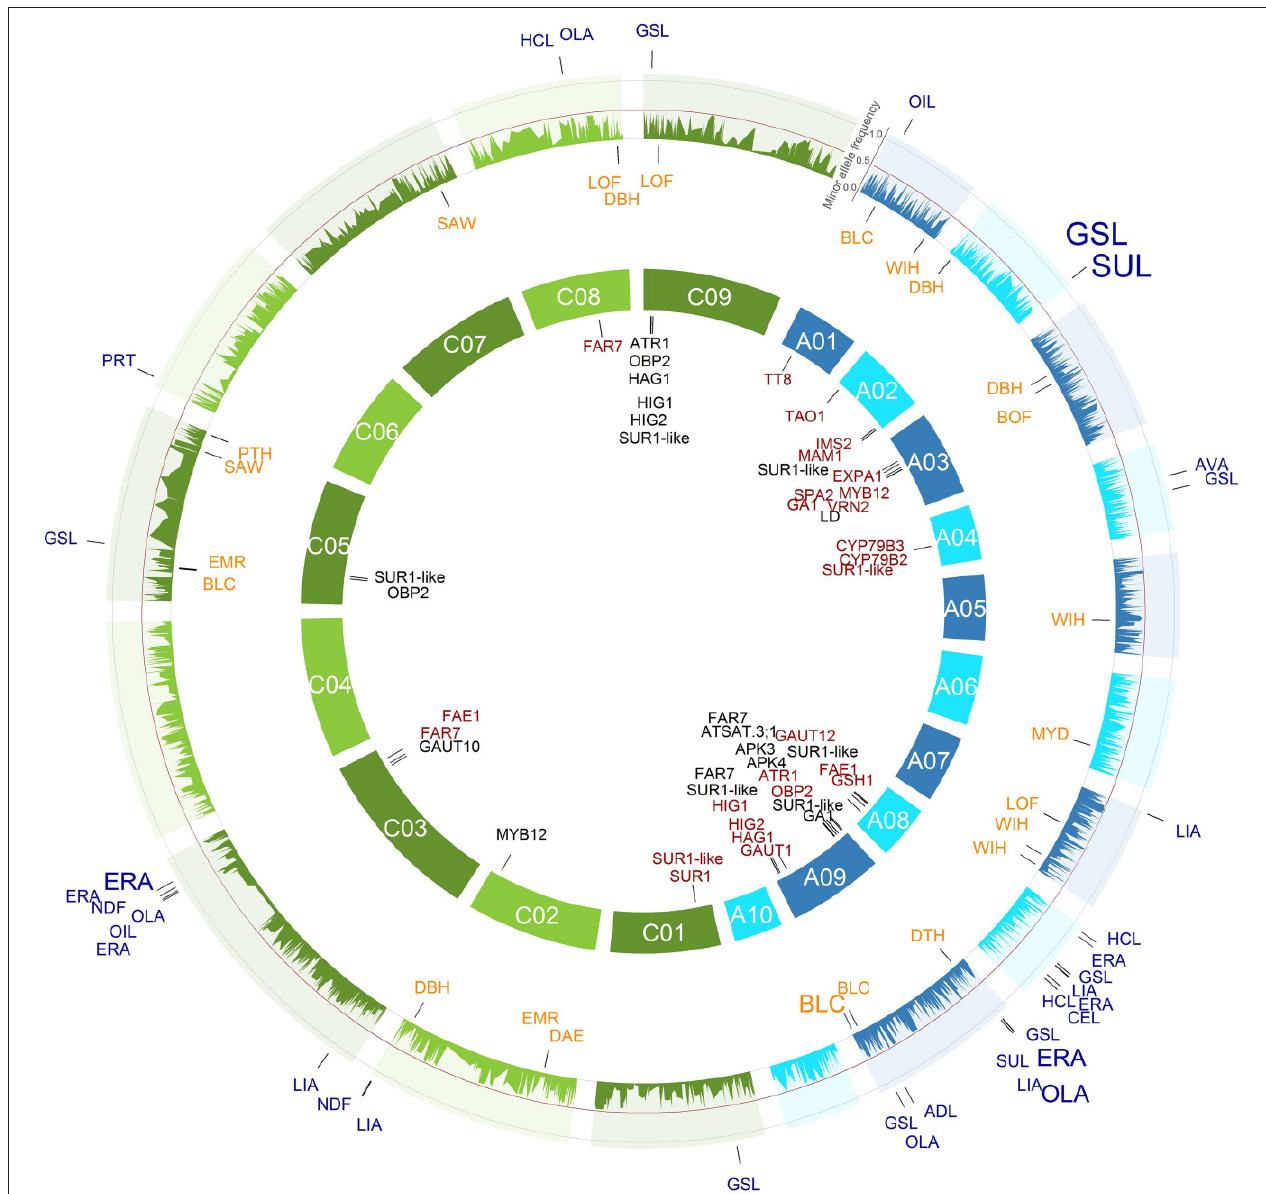
FIGURE 4 | All single nucleotide polymorphism (SNP)-trait associations with a P < 1.28e-05 (Bonferroni correction of α = 0.05 ) identified across the 214 inbreds of the winter trial and their respective positions are marked on the B. napus genome. The 3466 SNPs with their minor allele frequencies in the winter trial are given in the outer circle. The SNPs associated with the agronomic SNP-trait associations are plotted in orange below the allele frequency circle and the seed quality SNP-trait associations in blue outside the allele frequency circle. The size of the letters is related to the proportion of the variance explained by the associations. In the inner circle of the 19 chromosomes, the candidate genes were plotted to their mapping position on the B. napus reference genome. The A genome is colored blue and the C genome